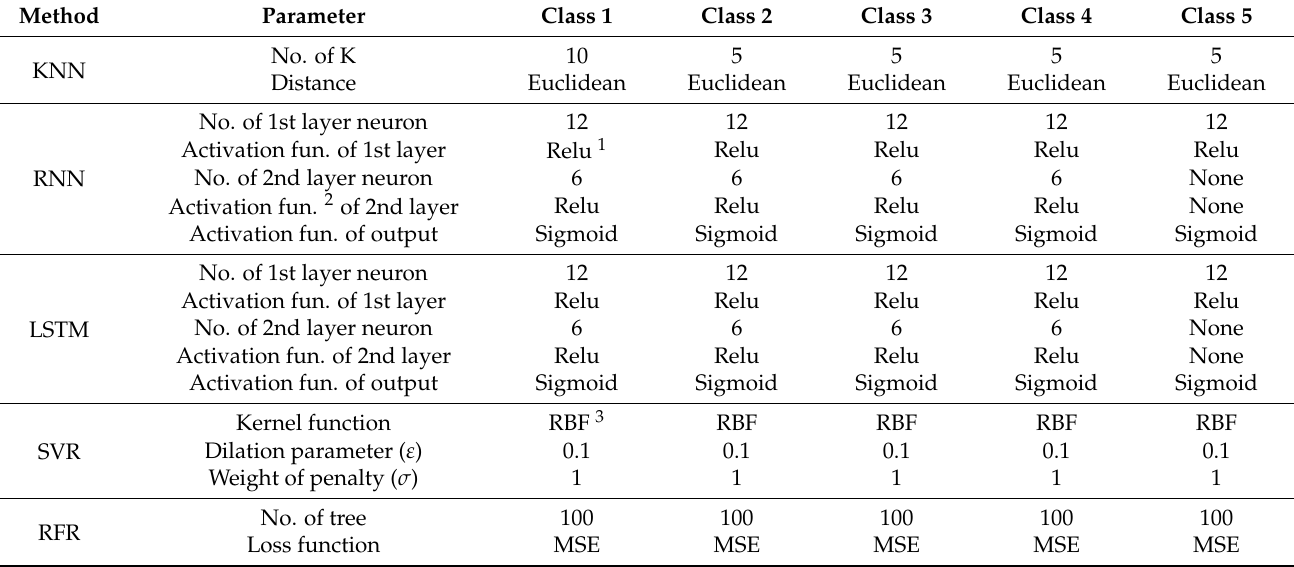
Table 5. Parameter settings for every single model.